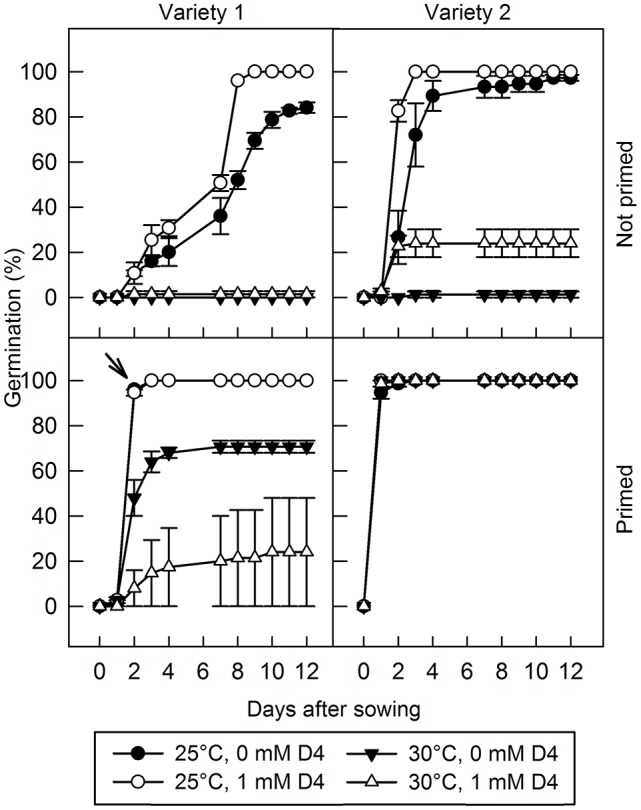
The effect of D4 and priming on germination of two lettuce varieties at permissive and thermodormancy-inducing temperatures. Lettuce seed of two different varieties were sown at 25°C and at 30°C with or without 1 mM D4, as indicated, and radicle emergence was scored. The arrow indicates where data for 0 mM D4 is obscured by the data for 1 mM D4 at 25°C. For the primed seeds of variety 2, much of the data overlaps due to rapid germination under all treatments. Bars indicate standard error (n = 3 plates each of 25 seeds).